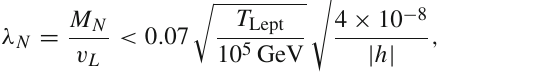
two-loop beta function for the running of λ (cid:9) H , which